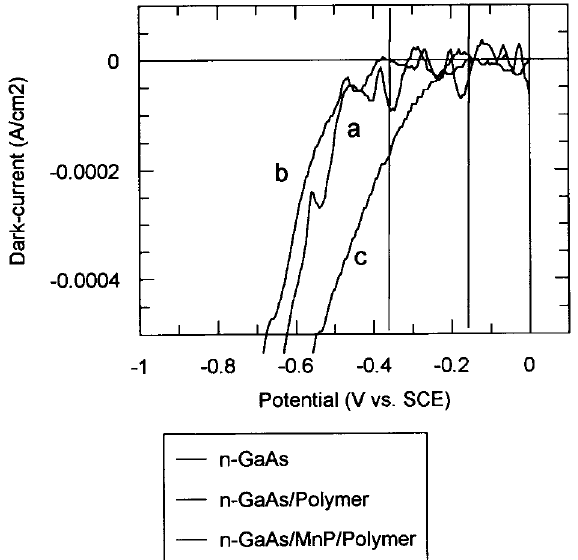
FIGURE 1 Dark-current vs. potential plots measured for (a) unmodified n-GaAs, (b) polymer-modified n-GaAs and (c) MnP = polymer-modified n-GaAs electrodes. All measurements were conducted in water = LiClO 4 = = Fe(CN) 4 (cid:2) in the dark at 25 (cid:3) Fe(CN) 3 (cid:2) 6 6